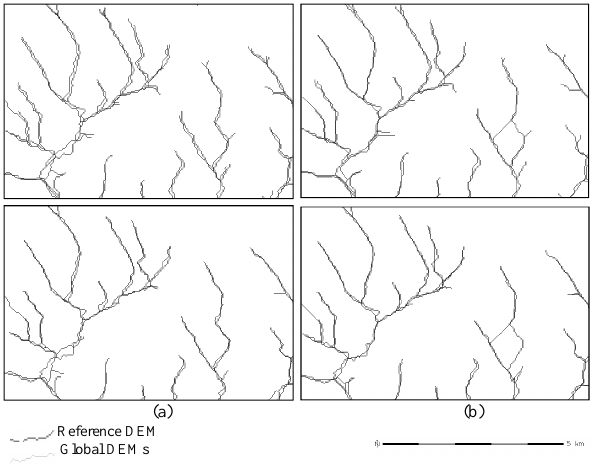
Figure 4. Comparing stream networks of the global DEMs and ref- erence DEM before (top panels) and after (bottom panels) shifting DEM: (a) GDEM, (b)